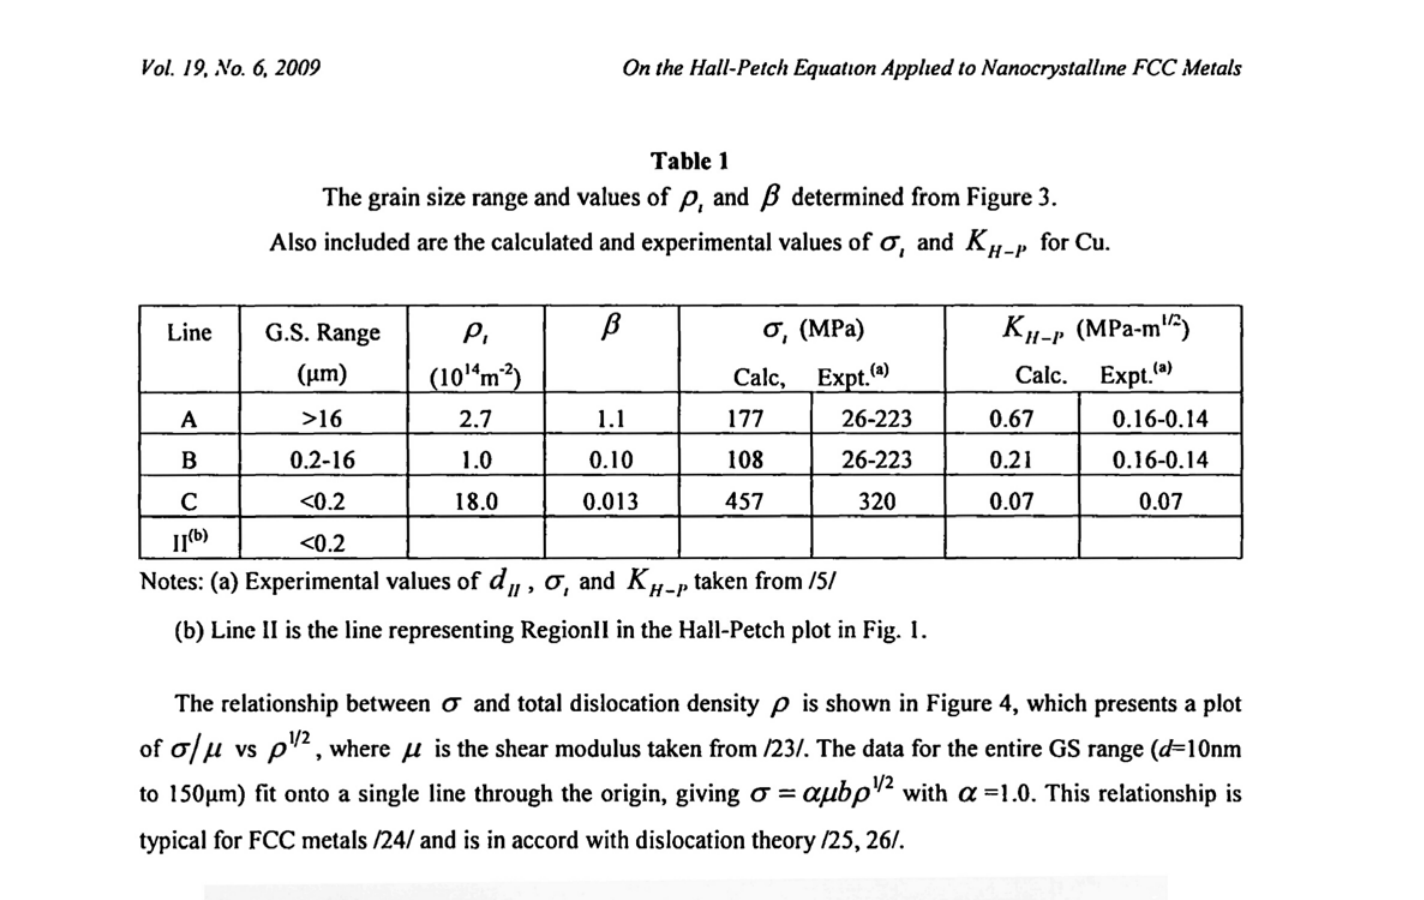
The grain size range and values of p